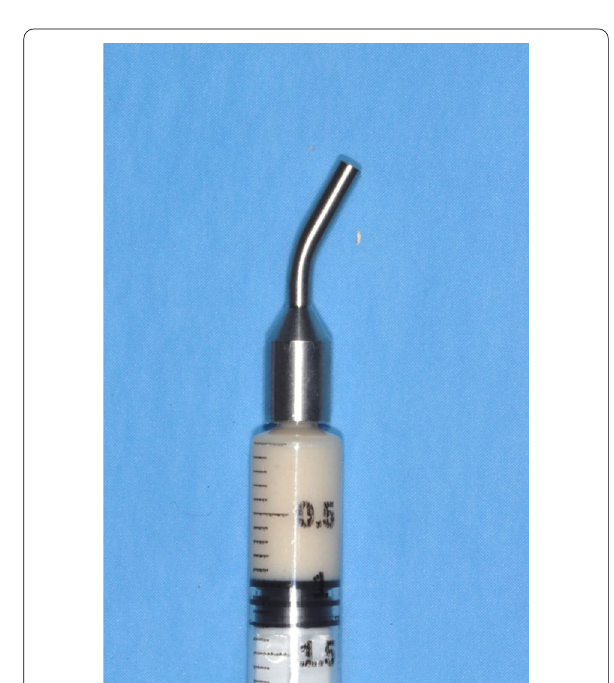
Fig. 2 Syringe of xenogenous porcine bone substitute in gel form with stainless steel insert to facilitate graft